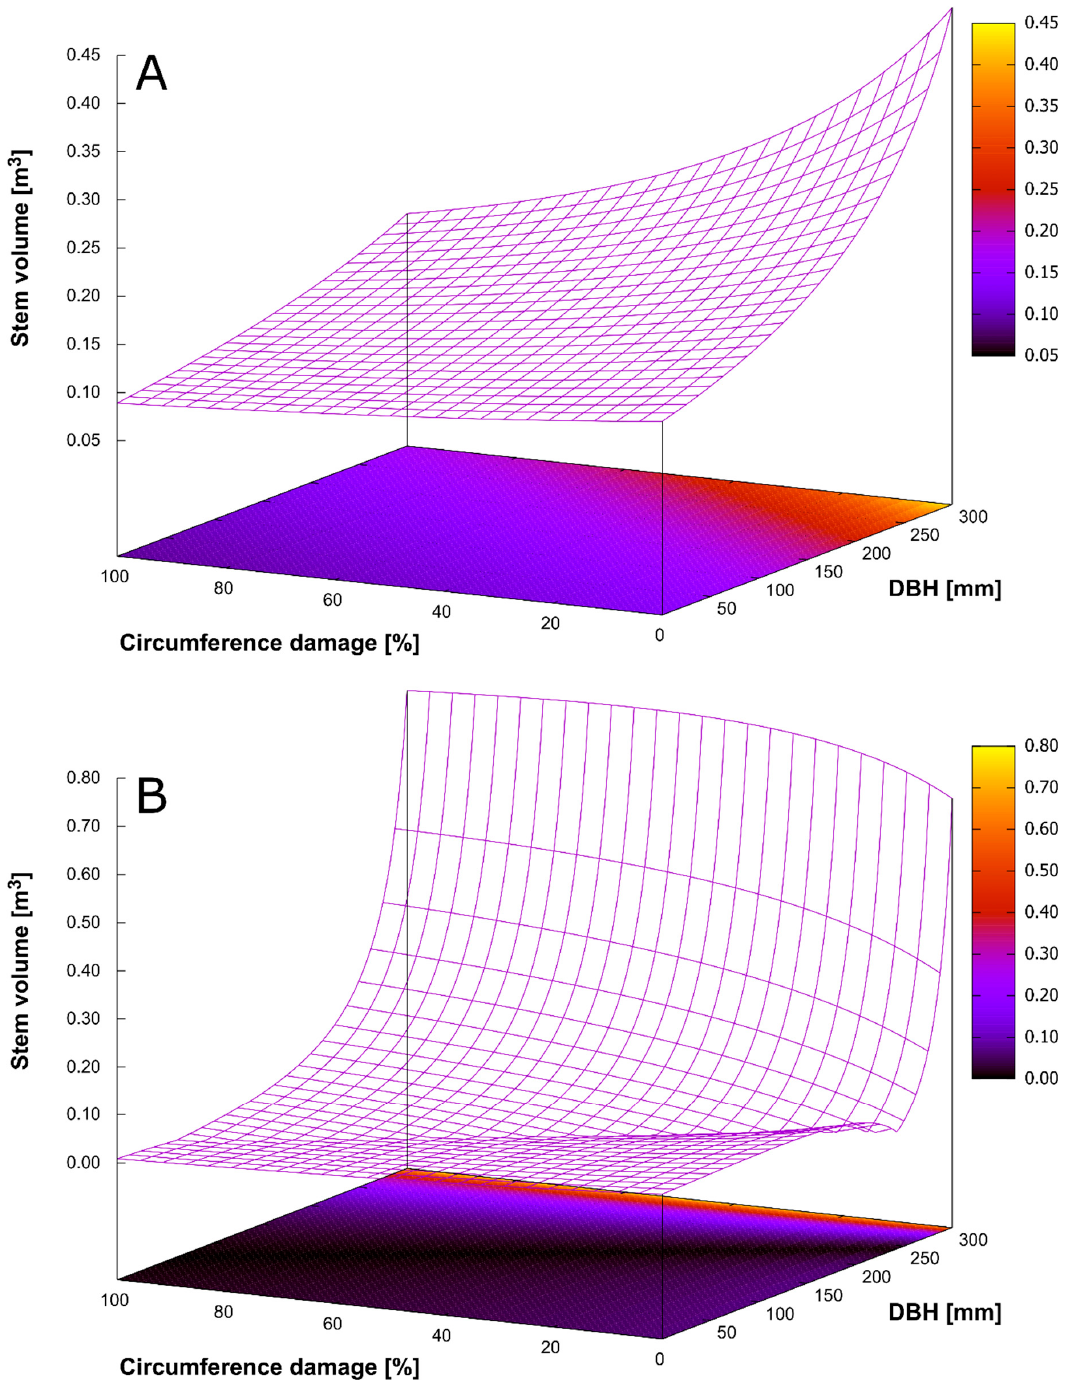
Figure 6. Graphical representation of the generalized linear model for stem volume prediction based on DBH and stem circumference damage ( A ) and the differences between separate models for LD and HD plots ( B